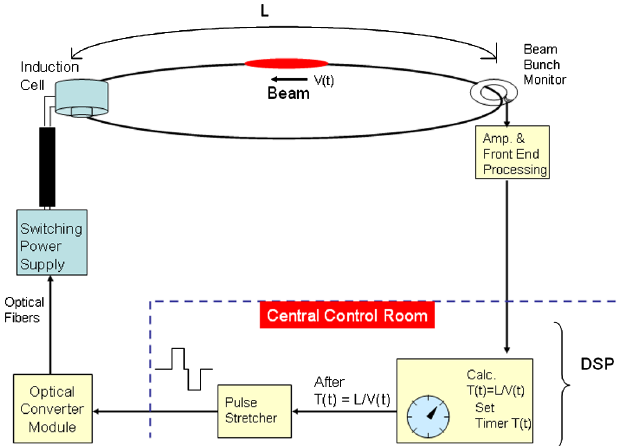
FIG. 36. Outline of the gate trigger system. When a beam with speed V ð t Þ is detected by a beam bunch monitor, the DSP sets its internal timer to make a delayed trigger signal: T [ ¼ L=V ð t Þ ], where L is the distance between the bunch monitor and the IC, and t denotes the time from the start of acceleration. The pulse stretcher forms the set/reset timing pulse and passes it to the switching power